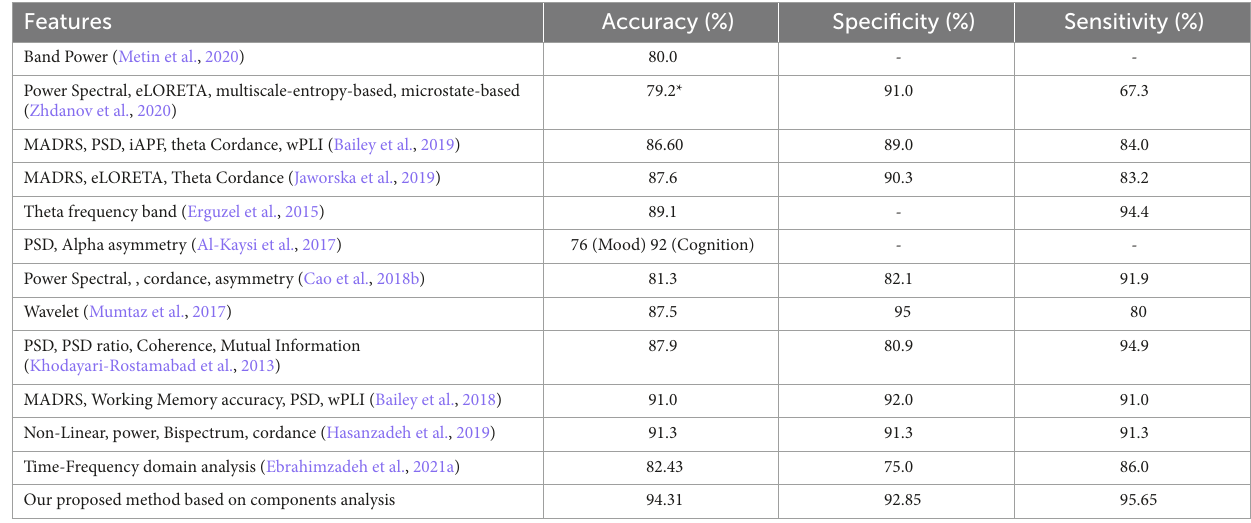
TABLE 7 Comparison of classification results of studies that applied machine learning techniques for prediction of MDD treatment response with those of the current study.